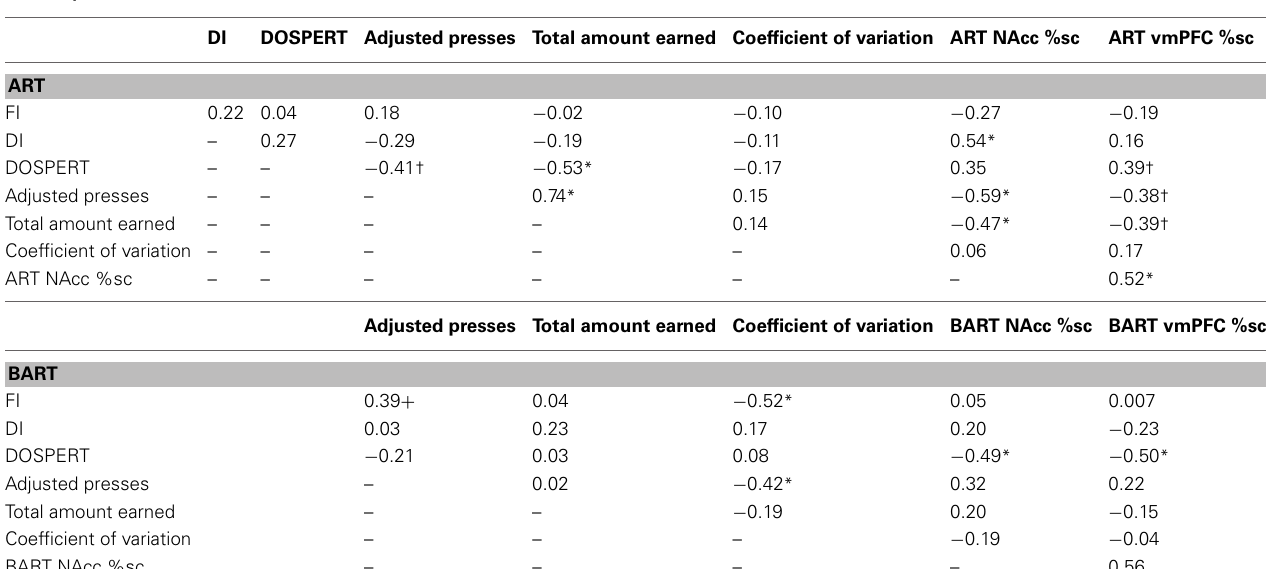
Table 4 | Correlations among individual differences